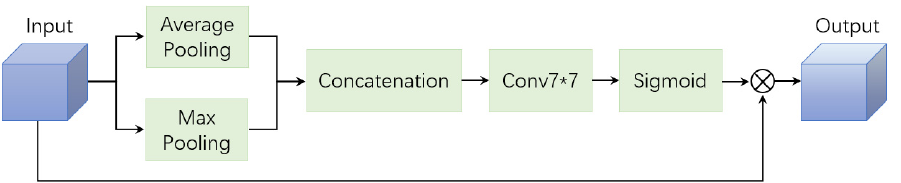
Figure 2. The attention block(AM) adopted by Y-UNet. Conv7 × 7: convolution with kernel size 7 ×